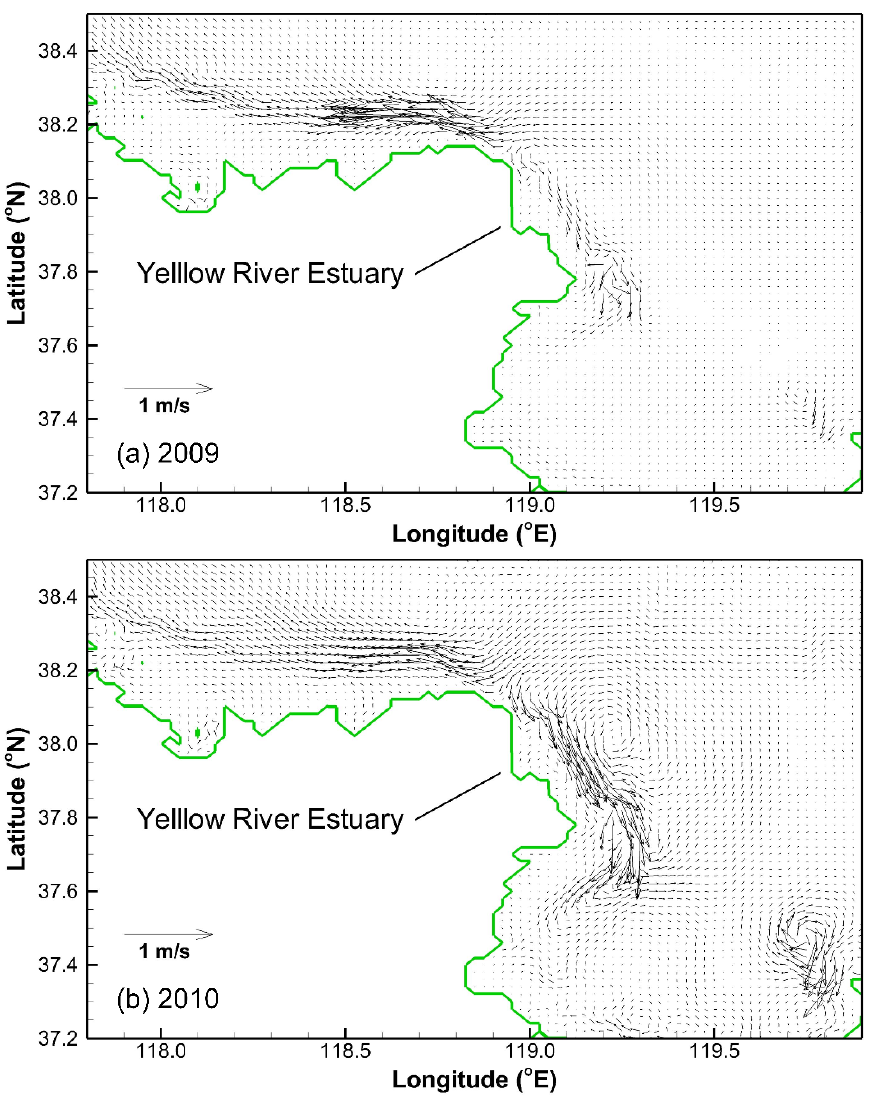
Figure 8. Longshore currents near the Yellow River estuary (at the time step for which the surge in the south Bohai Sea peaks).